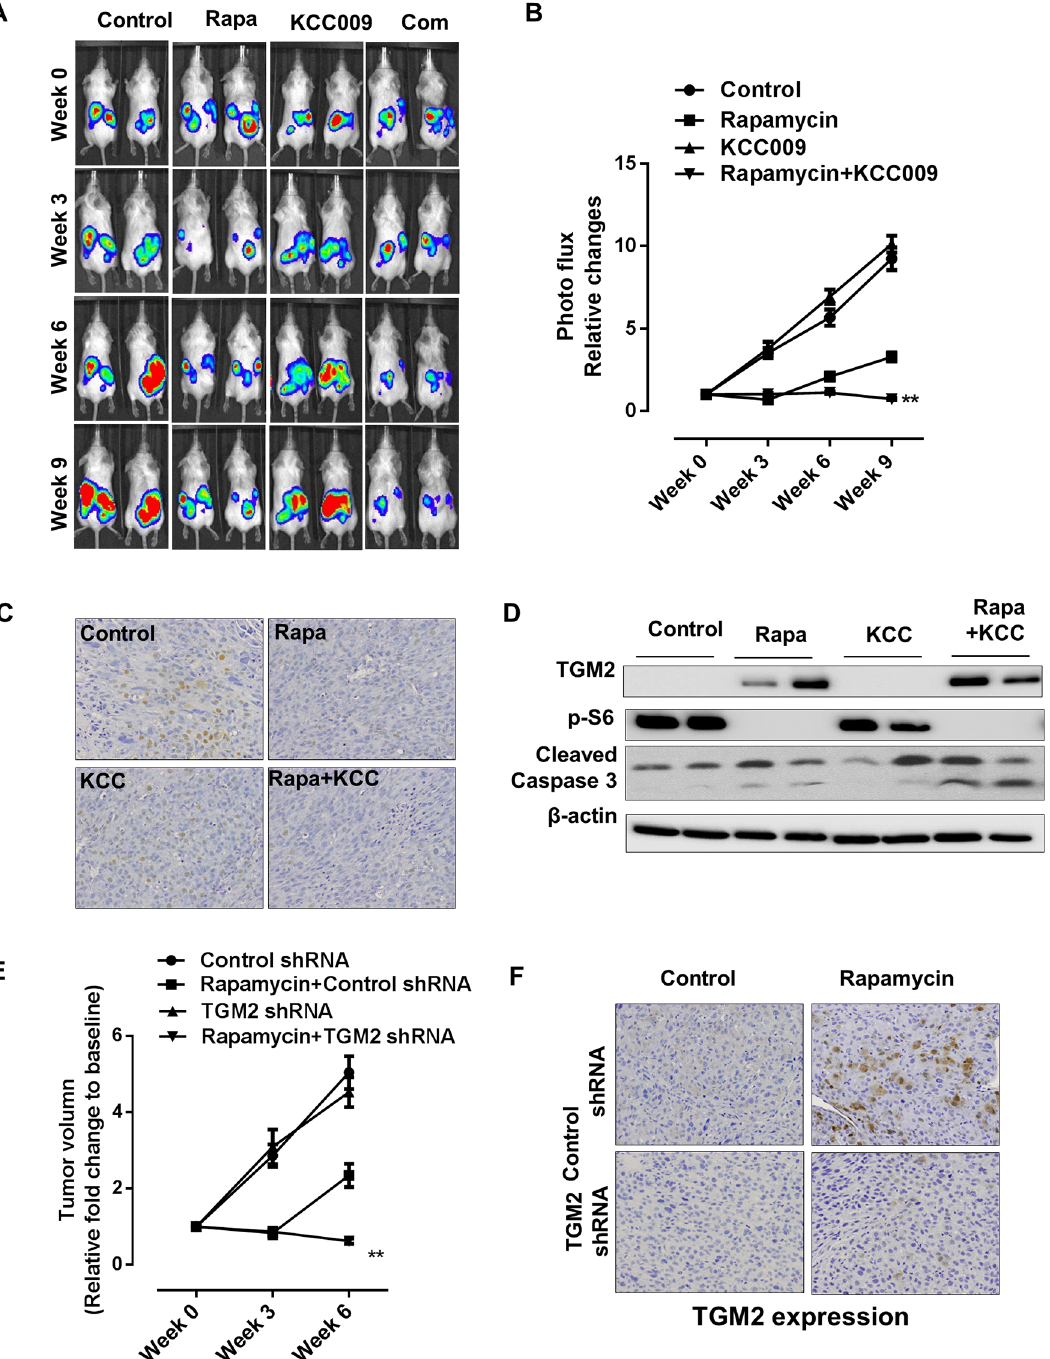
Fig 6. Dual inhibition of mTORC1 and TGM2 causes xenograft tumor regression. Female CB17-scid mice were s.c. inoculated with luciferase-labeled MCF-7 cells. Mice were treated with vehicle, rapamycin, KCC009, or rapamycin and KCC009 for 9 weeks. (A and B) Representative images of mice bearing MCF-7 xenograft tumors treated with vehicle control, rapamycin, KCC009, or rapamycin and KCC009. Xenograft tumor bioluminescent intensity was recorded and quantified every three weeks. The y-axis indicates relative tumor growth vs. the baseline quantification before drug treatment (n = 8). (C) Representative images of immunohistochemical staining for cell proliferation marker PCNA in tumors from mice treated with vehicle, rapamycin, KCC009, or rapamycin and KCC009. (D) Immunoblot of tumor lysates for TGM2, p-S6, and cleaved caspase 3 in tumors from mice treated with vehicle, rapamycin, KCC009, or rapamycin and KCC009. (E) Mice were inoculated with control or TGM2 shRNA knockdown stable MCF-7 cell lines. Vehicle control or rapamycin was applied to mice with tumor burden. Tumor volume (relative fold change to baseline) was recorded and quantified every three weeks until